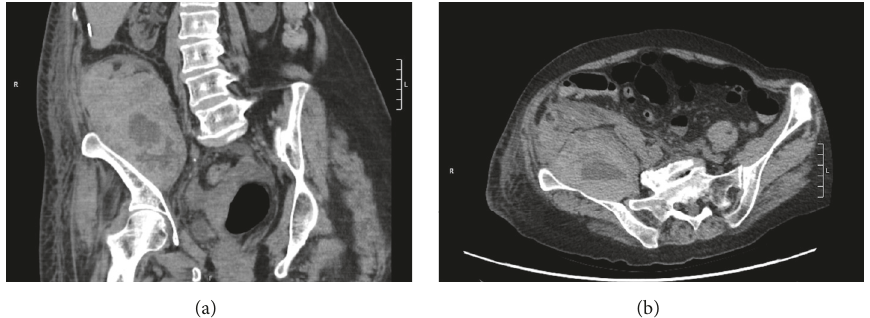
Figure 1: Computed tomography images without contrast in coronal plane (a) and axial plane (b) demonstrating right-sided iliopsoas hematoma as presented in case 1 .